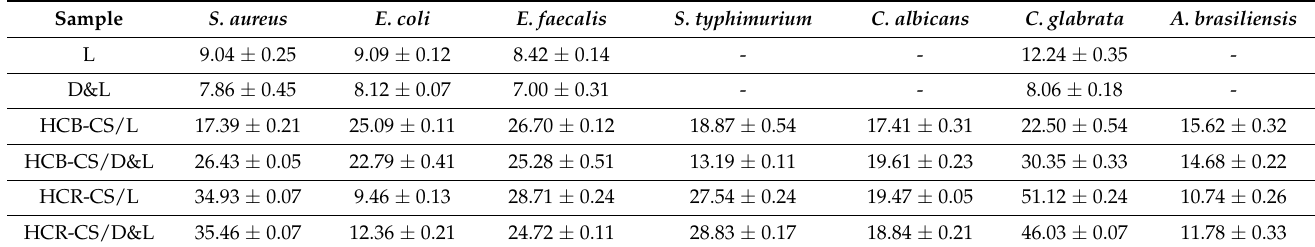
Table 5. Results of antimicrobial testing.